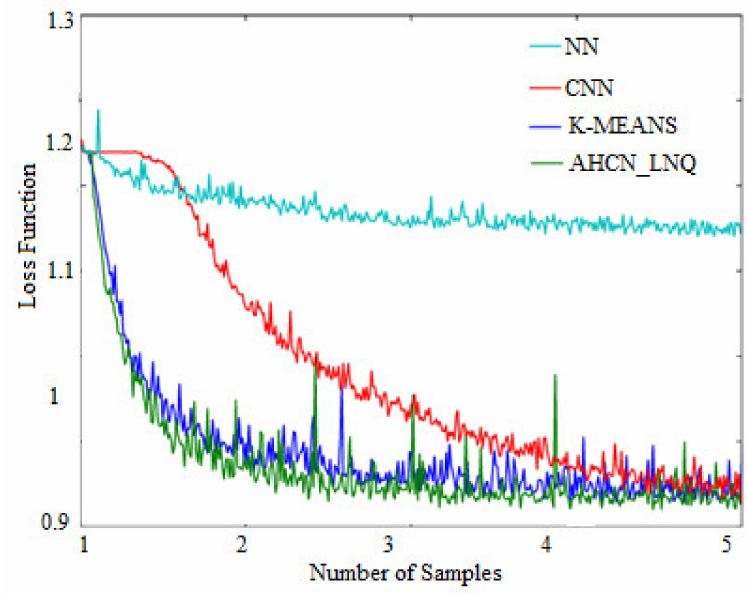
Figure 10. Loss function of testing